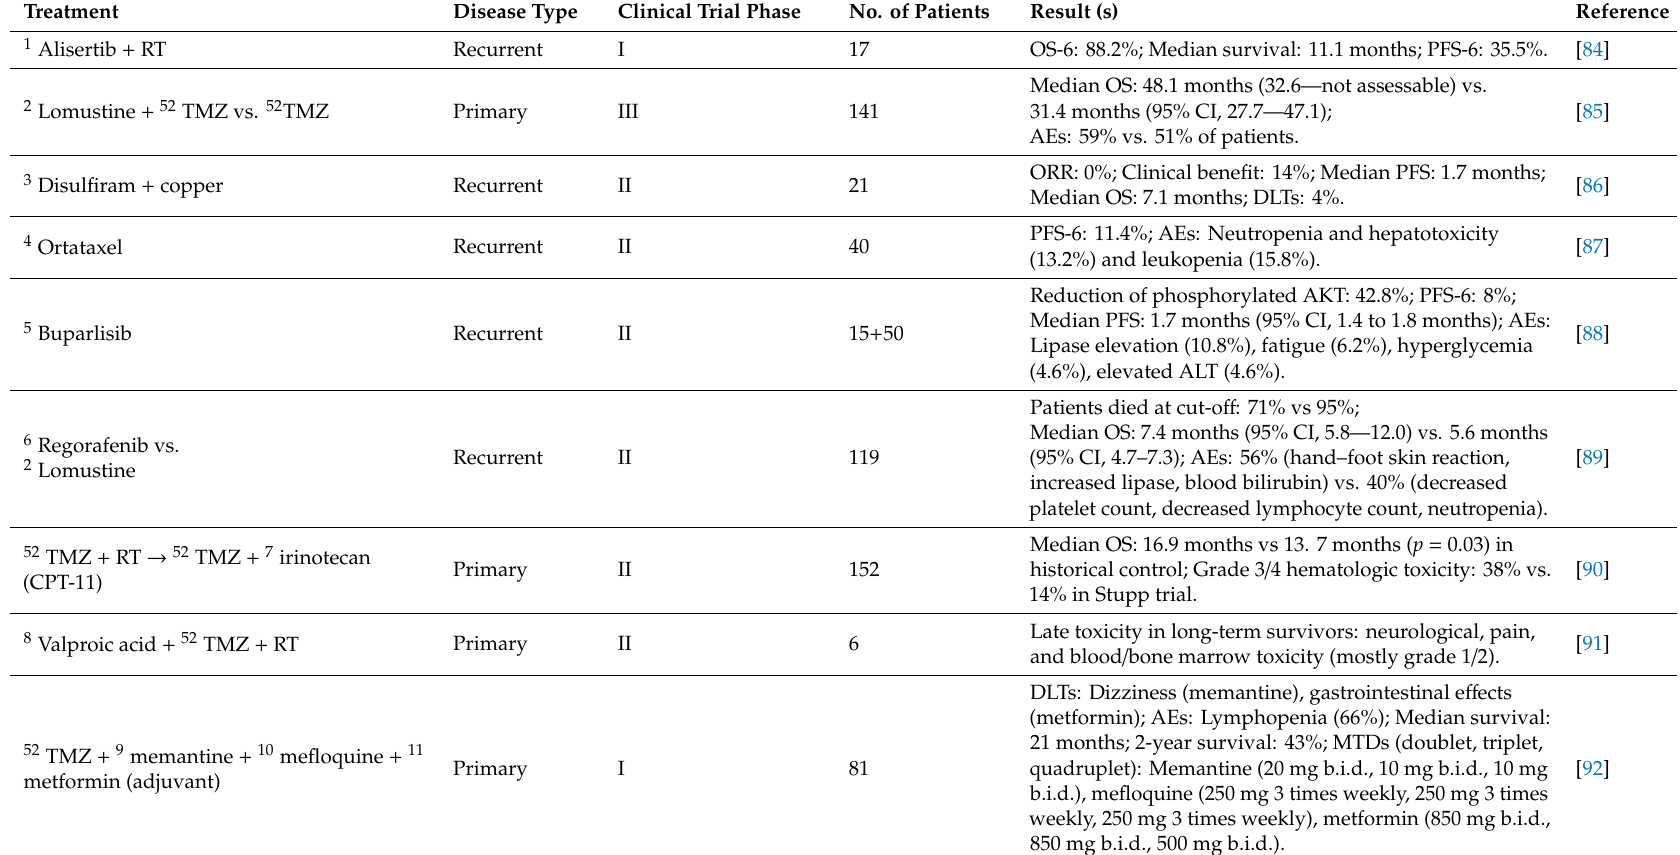
Table 2. Published major clinical trials of targeted therapies from January 2017 to December